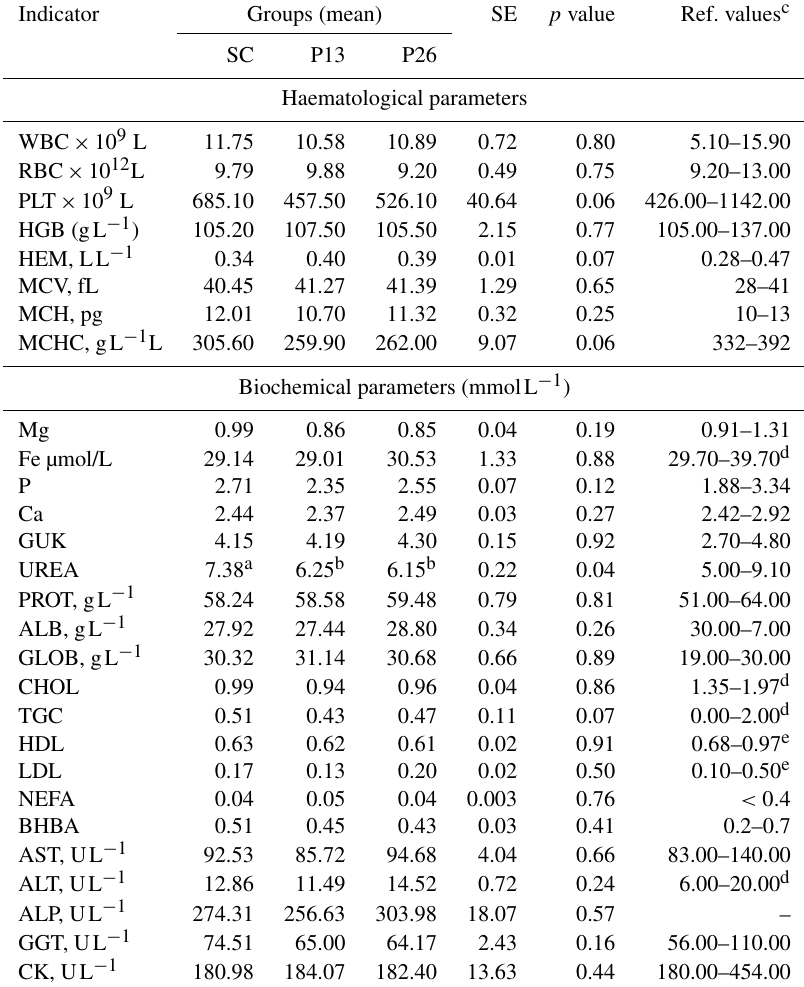
Table 4. Blood metabolic profile in lambs.